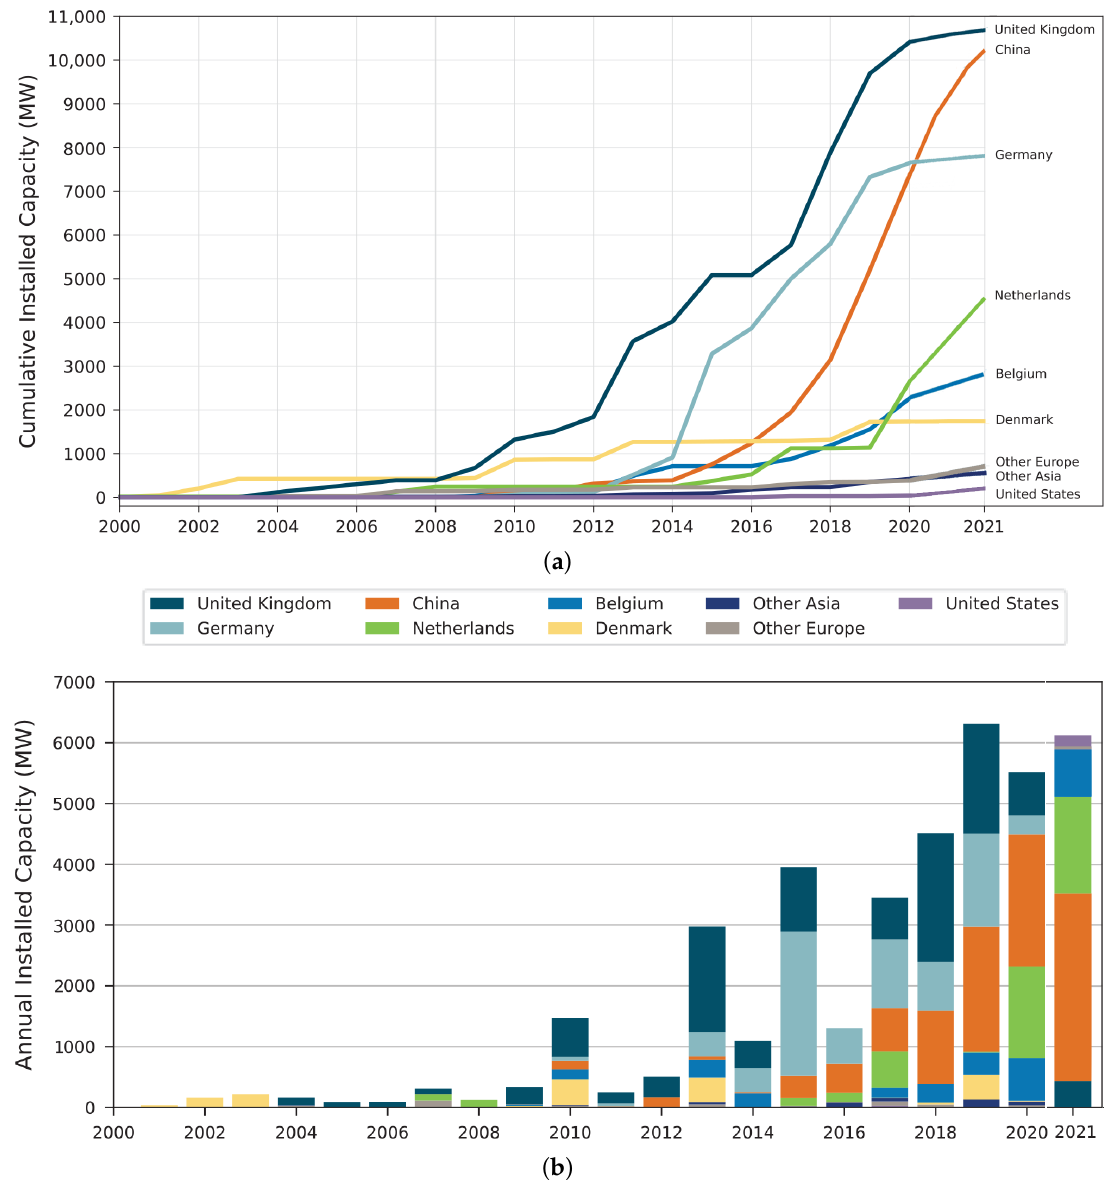
Figure 1. Global cumulative offshore wind energy deployment and annual capacity trends through 2021 [8]. ( a ) Cumulative installed wind energy trends for countries with the highest record in the past two decades. ( b ) Annual new installation trends for countries with the highest record in the past two